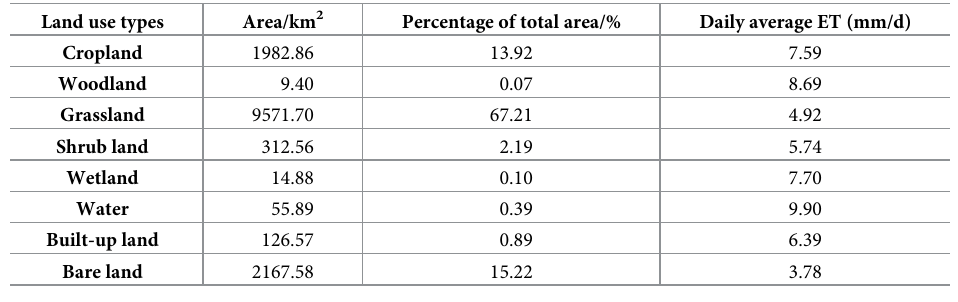
Table 5. Daily evapotranspiration data for different land use